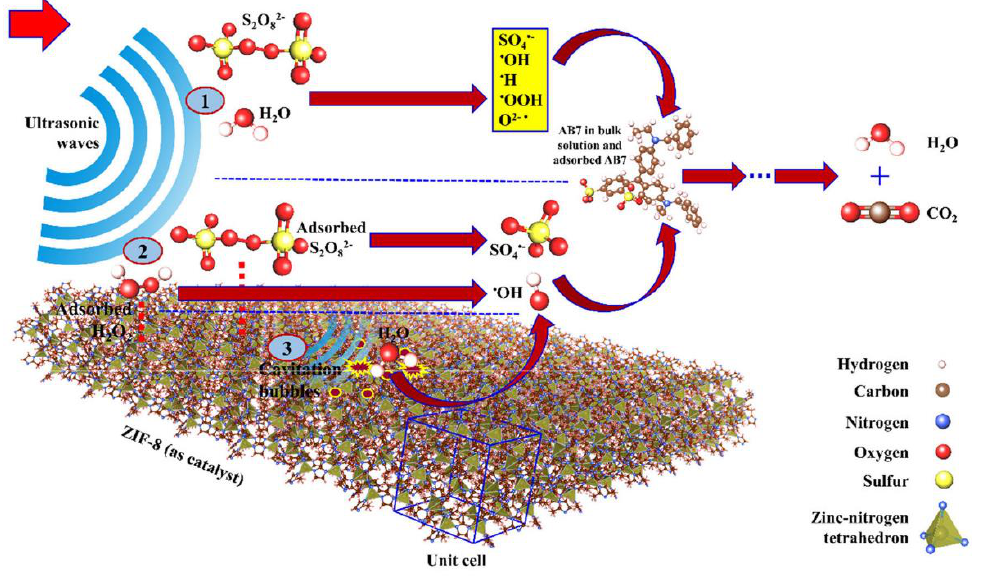
Figure 6. Heterogeneous and homogeneous decomposition mechanism for H 2 O and PDS molecules on a catalyst surface and bulk solution, causing the constant creation of active oxidizing samples (paths (1) to (3)) [127].